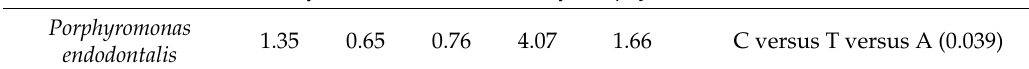
Statistical Analysis Produced p -Values <